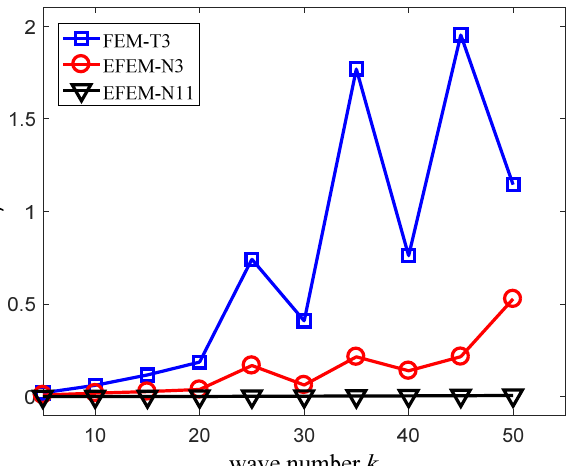
Figure 8. Comparison of the calculated global error results from different methods versus the wave number k.